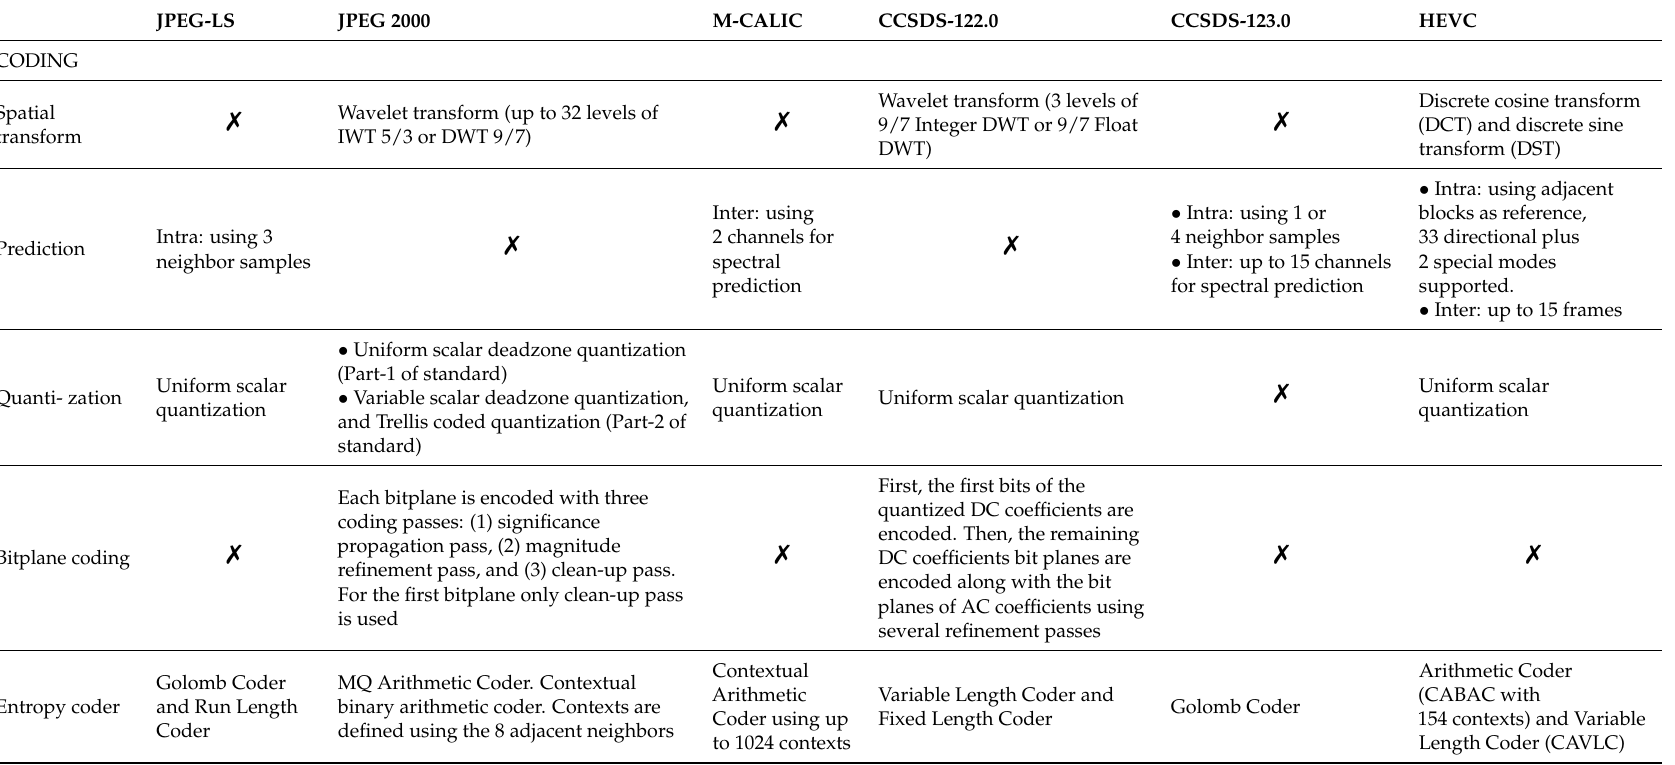
Table 3. Technical characteristics of the considered compression techniques